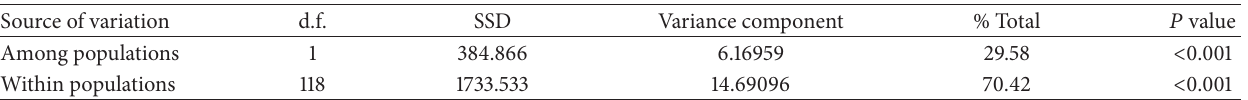
Table 3: Analysis of molecular variance (AMOVA) for 120 individuals sampled from two populations of Calophyllum brasiliense using RAPD molecular markers.